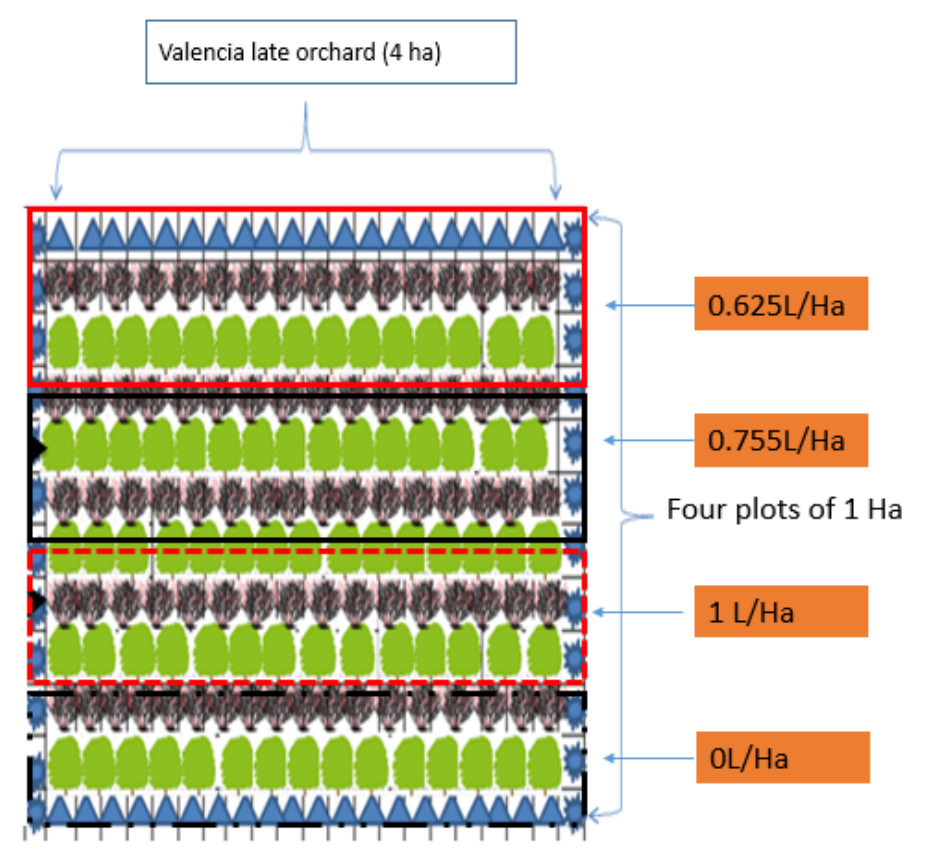
Figure 2. Model of the monitored orchard (divided into four small plots of 1 ha) and used doses of spirotetramat (T0 = 0 L/ha, T1 = 0.625 L/ha, T2 = 0.755 L/ha, and T3 = 1 L/ha).